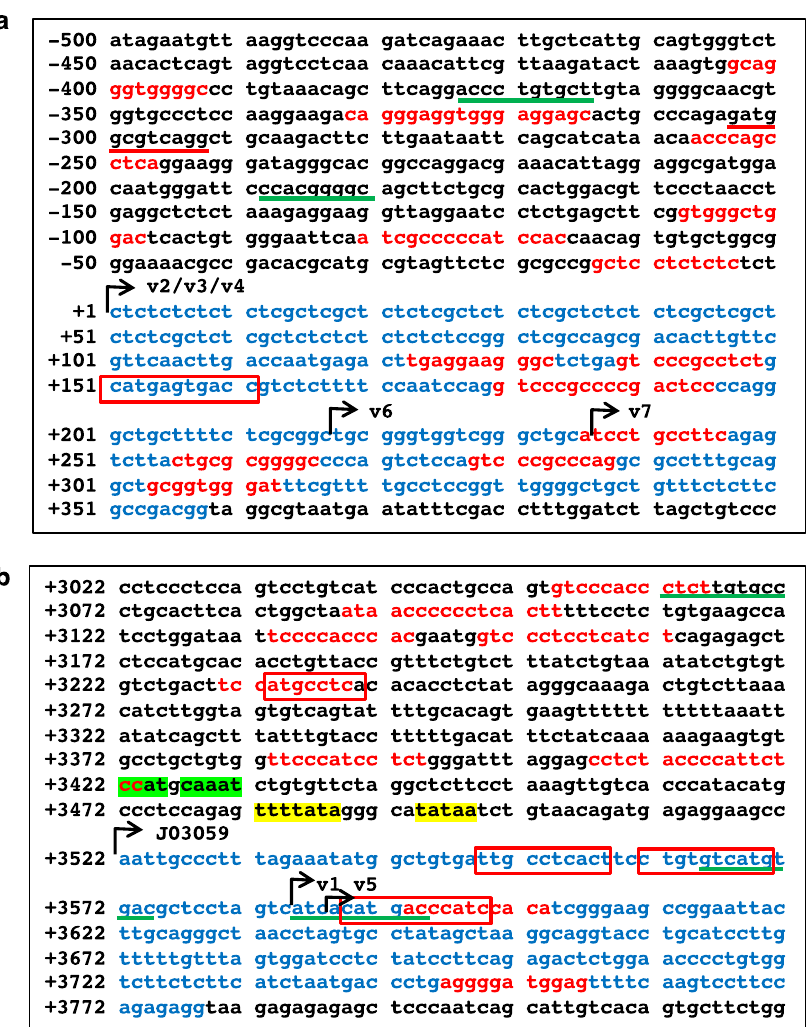
Fig. 2 TSSs of GBA variants in the P1 and P2 promoter regions. Panels ( a , b ) indicate P1 and P2 promoter regions spanning 500 bp with the following exon sequences, respectively. The most upstream TSS from P1 promoter is designated as + 1, and the following sequence positions are indicated to the right side. Arrows, individual TSSs of the variants (v); blue letters, exon sequences; red letters, SP1 binding sites; yellow highlights, TATA box; green highlights, CAAT box; red boxes, AP1 (JUN/FOS) binding sites; red underlines, CREB binding sites; green underlines, TFEB binding